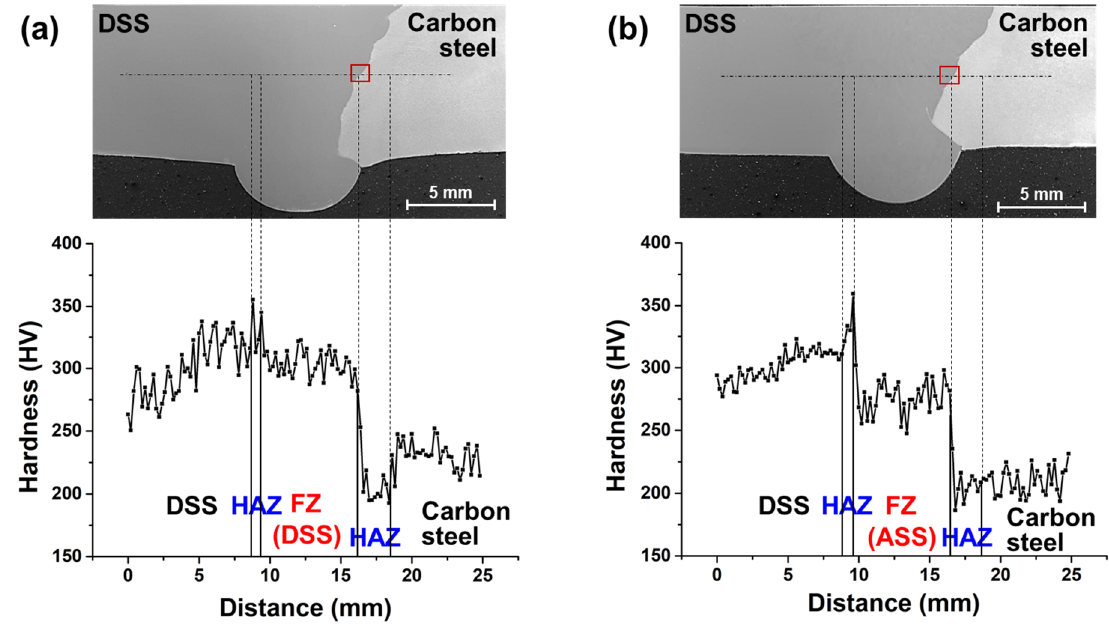
Figure 3. Vickers hardness of the WJs with the ( a ) DF and ( b ) AF.